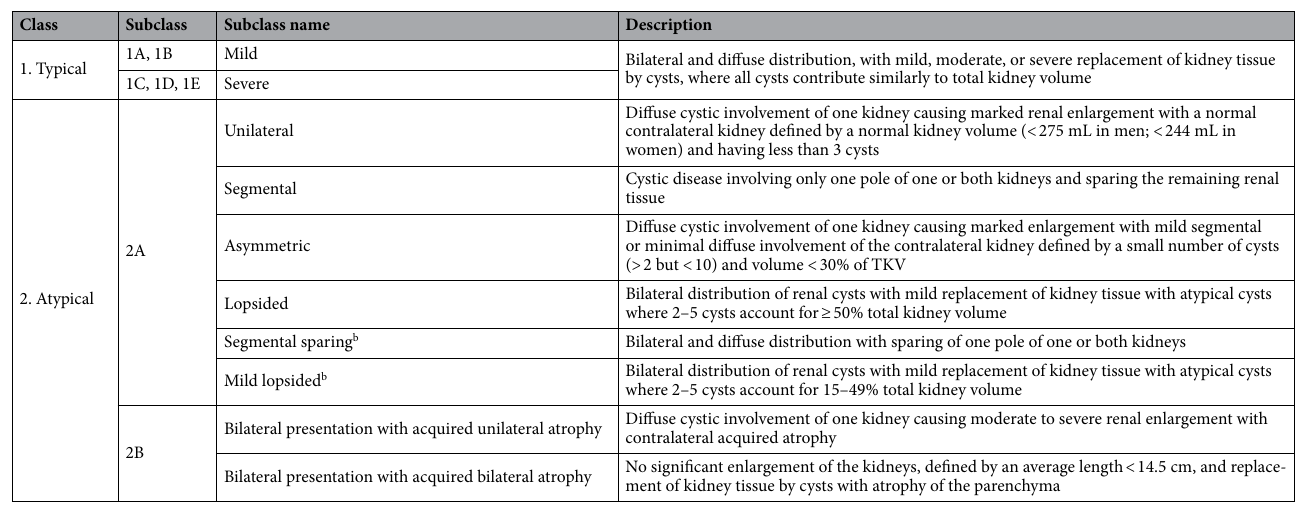
Table 1. Toronto updated classification of cystic kidney imaging patterns a . a Adapted from the Mayo Clinic Imaging Classification; b two new patterns added in the current study.